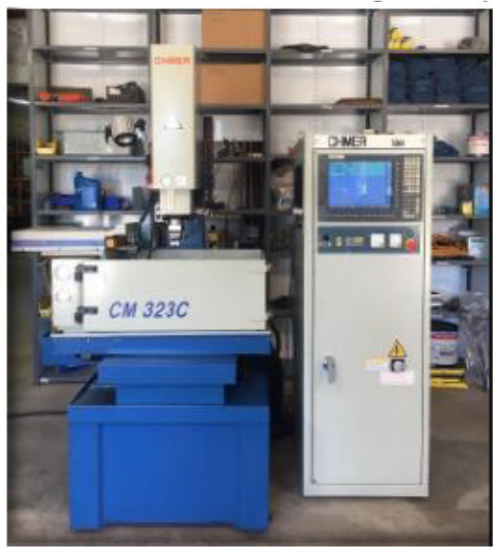
parameters values and the levels used Process